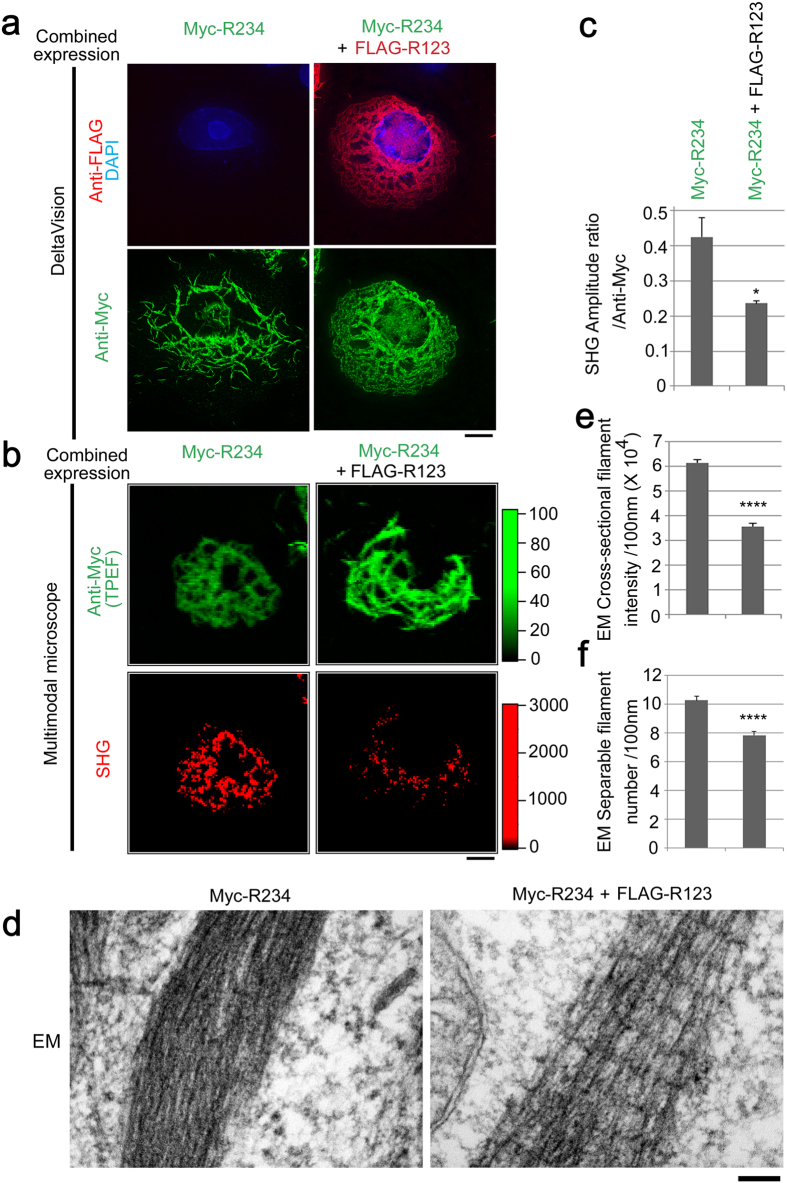
SHG induction shows quantitative agreement with the density of R234 filaments.(a) Standard immunofluorescence highlighted unsharpened Myc-R234 filaments co-expressed with the FLAG-R123 domain. Anti-Flag (red), Anti-Myc (green), DAPI (blue). (b) SHG induction was weaker under co-expression. TPEF (green), SHG (red). (c) Quantitative reduction of SHG in (b), compared to Myc intensity in each cell. (d) Electron micrograph depicting ultrastructural alteration due to FLAG-R123 co-expression: (left) pure R234 formed packed filaments; (right) FLAG-R123 co-expression resulted in formation of more widely spaced filaments with additional cross-striations, similar to the case of full-length Rootletin (Fig. 3a). (e and f) Quantitation of filaments in (d), as both intensity (e) and number (f) note the correlation to SHG in c. Bars, 10 μm in (a and b), and 100 nm in (d). Error bars represent s.e.m. *P < 0.05 in (c), ****P < 0.001 in (e and f). N = 5, 30, and > 28 in (c,e and f), respectively. Color scales indicate intensity (a.u.).